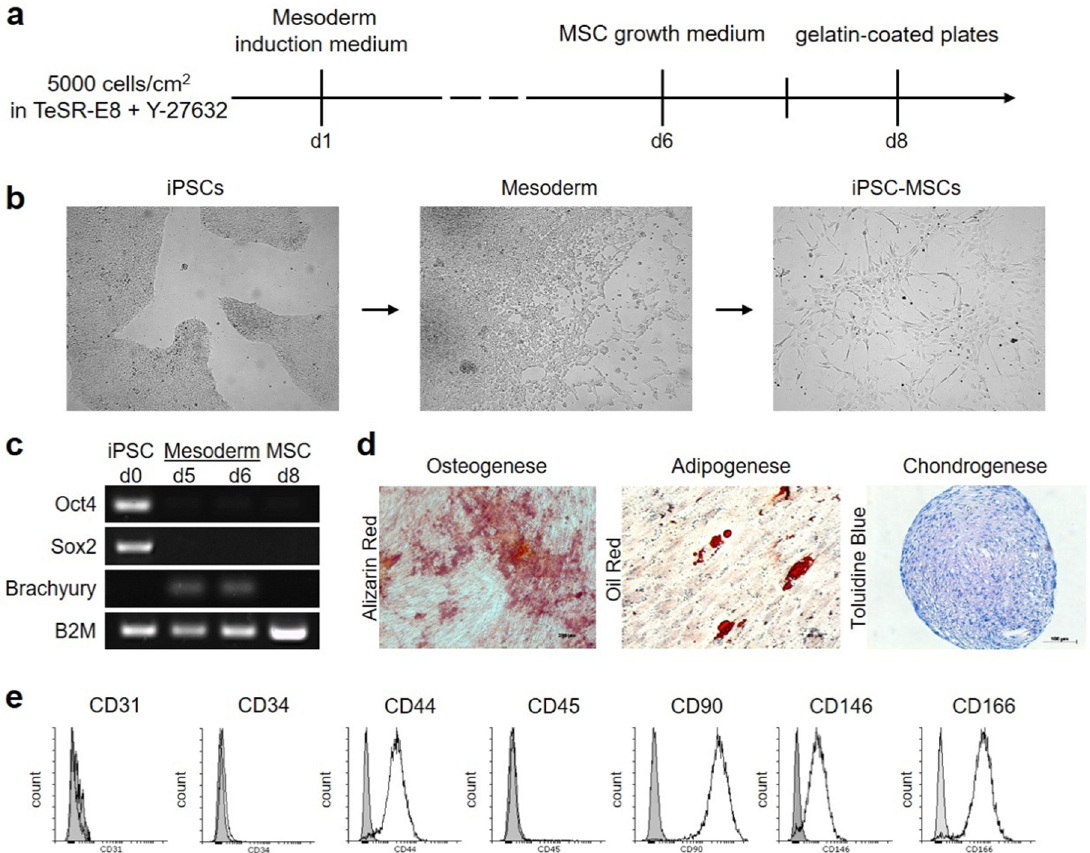
Figure 2. Induction of iPSCs into MSC-like cells. ( a ) Schematic differentiation protocol of iPSCs to iMSCs. ( b ) Light microscopy images demonstrating the cell morphology changes occurring during the development of iPSC to hiPSC-MSCs. Representative cell morphology of iPS cells prior to induction. A representative image of the cell morphology of mesoderm cells after induction with Mesoderm Induction Medium. ( c ) Gene expression of different cell types (Oct4: octamer-binding transcription factor 4, Sox2: sex determining region Y-box 2, B2M: Beta-2-Microglobulin). ( d ) Multilineage differentiation of iMSCs. ( e ) Flow cytometric analysis of surface markers of hiPSC-MSCs (white: iMSCs, grey: negative control).